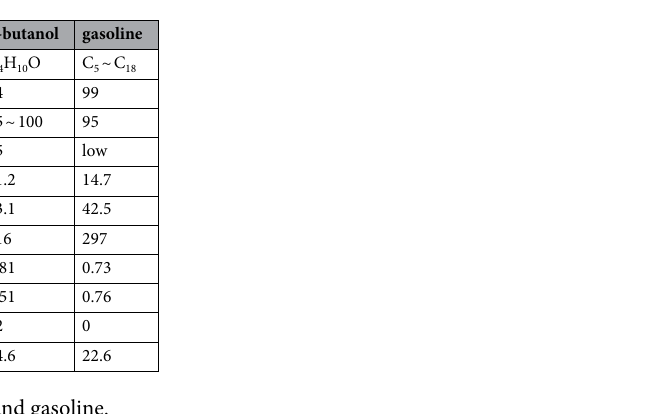
Table 2. Properties of n-butanol and